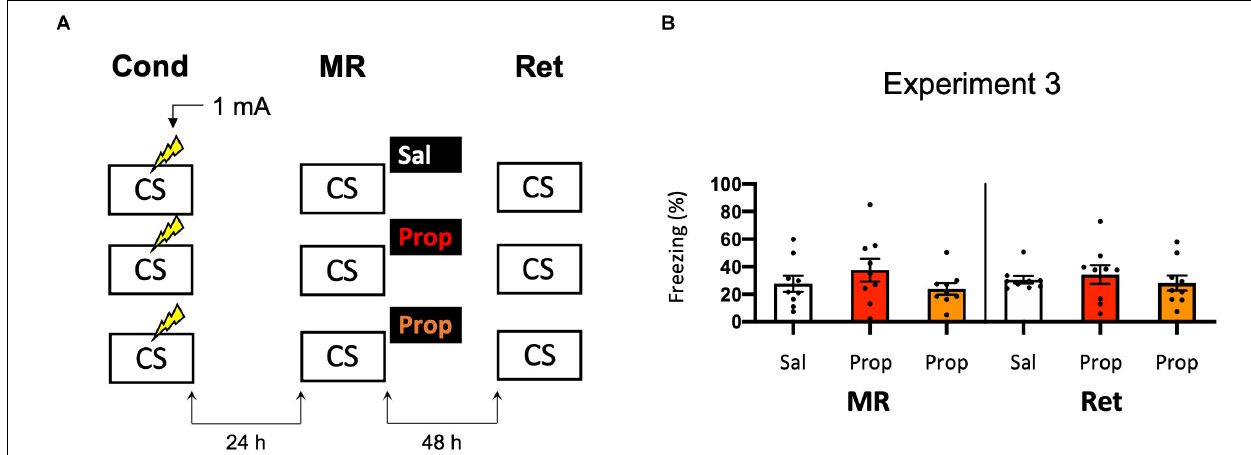
FIGURE 3 | No effect of propranolol—injected in two different volumes—on reactivated memories that were acquired with a single 1 mA shock during contextual fear conditioning. (A) Design of Experiment 3. Mice received one 1 mA shock during fear conditioning. One day later, mice received saline ( n = 9), propranolol ( n = 9), or propranolol dissolved in saline at half the ratio and injected in double the volume/body weight ( n = 9) after memory reactivation. Forty-eight hours afterward, retention of contextual fear was assessed. Cond, conditioning; MR, memory reactivation; Ret, retention; CS, conditioned stimulus (context); Sal, saline; Prop, propranolol. (B) Results of Experiment 3. Average percentage of freezing during memory reactivation is displayed on the left, and freezing during the retention test on the right panel of the column chart (saline in white bars, propranolol in red bars, and propranolol double volume in orange bars). Error bars represent SEM. Filled circles indicate individual animals.